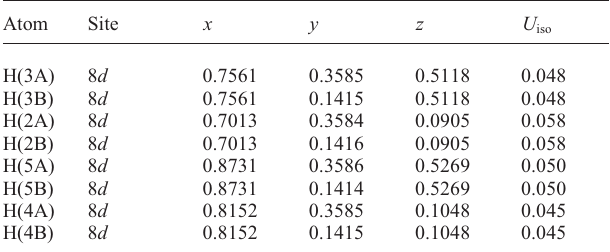
Table 2. Atomic coordinates and displacement parameters (in Å 2 )